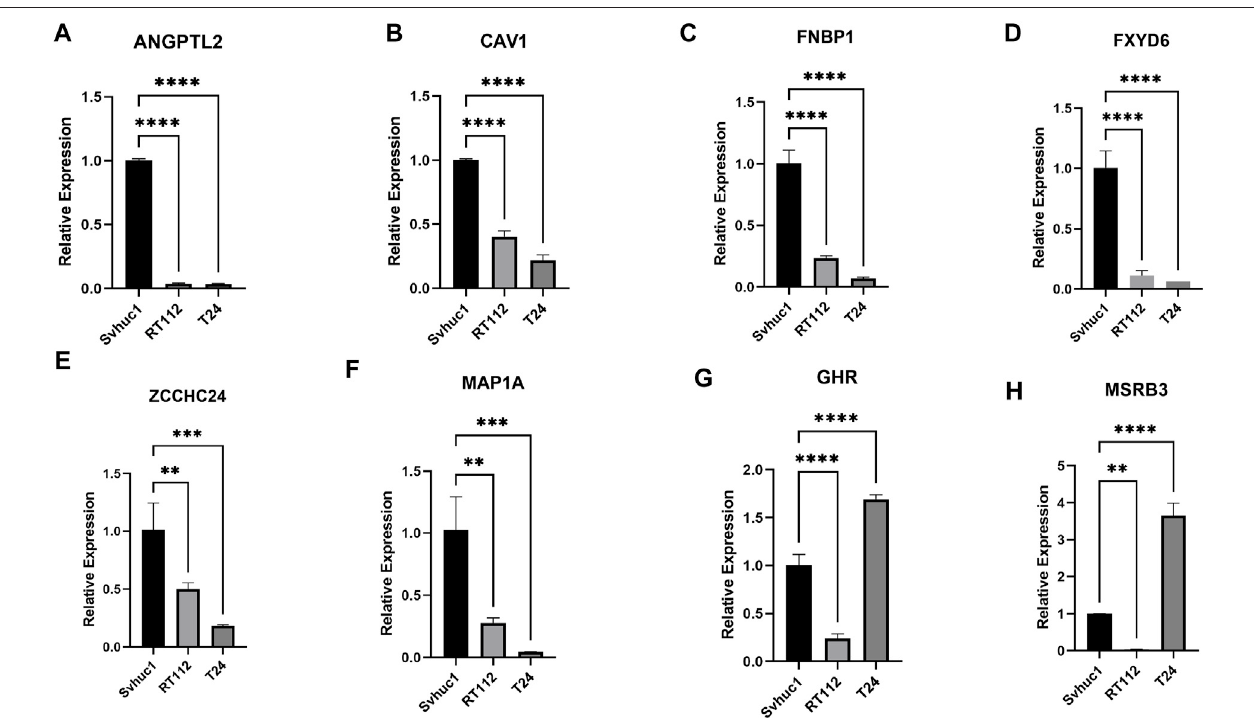
FIGURE 9 | (A – H) The relative expression levels of the feature genes in Svhuc-1, RT112, and T24 cells were detected by qRT – PCR. (* p < 0.05, ** p < 0.01, *** p < 0.001, **** p < 0.0001).